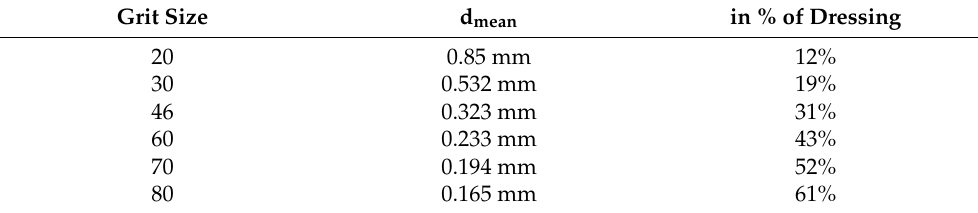
Table 3. Fixed dressing depth of 0.1 mm recalculated in terms of percentual values.